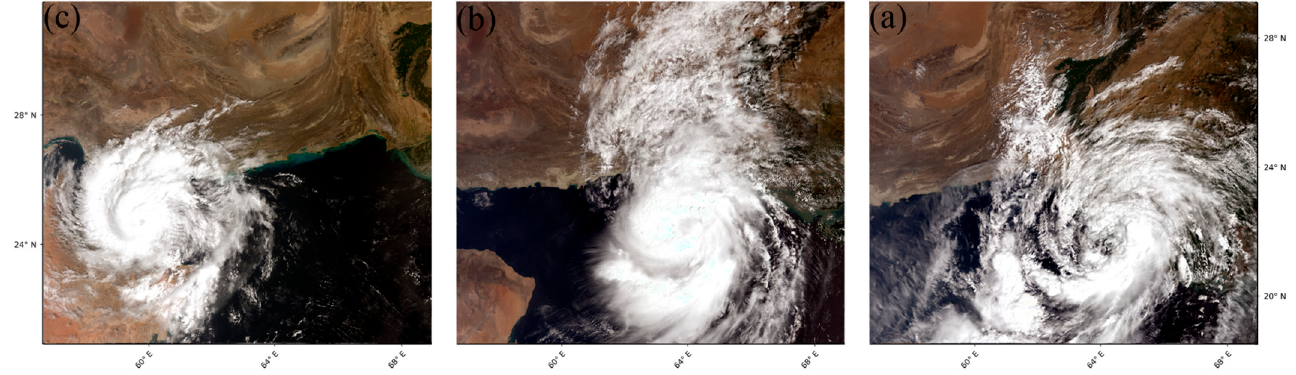
Figure 2. Cyclone Shaheen at 0500 UTC ( a ) on 30 October ( right panel), ( b ) on 1 September ( middle panel), and ( c ) on 3 September 2021 ( left panel) as observed by Sentinel-3.